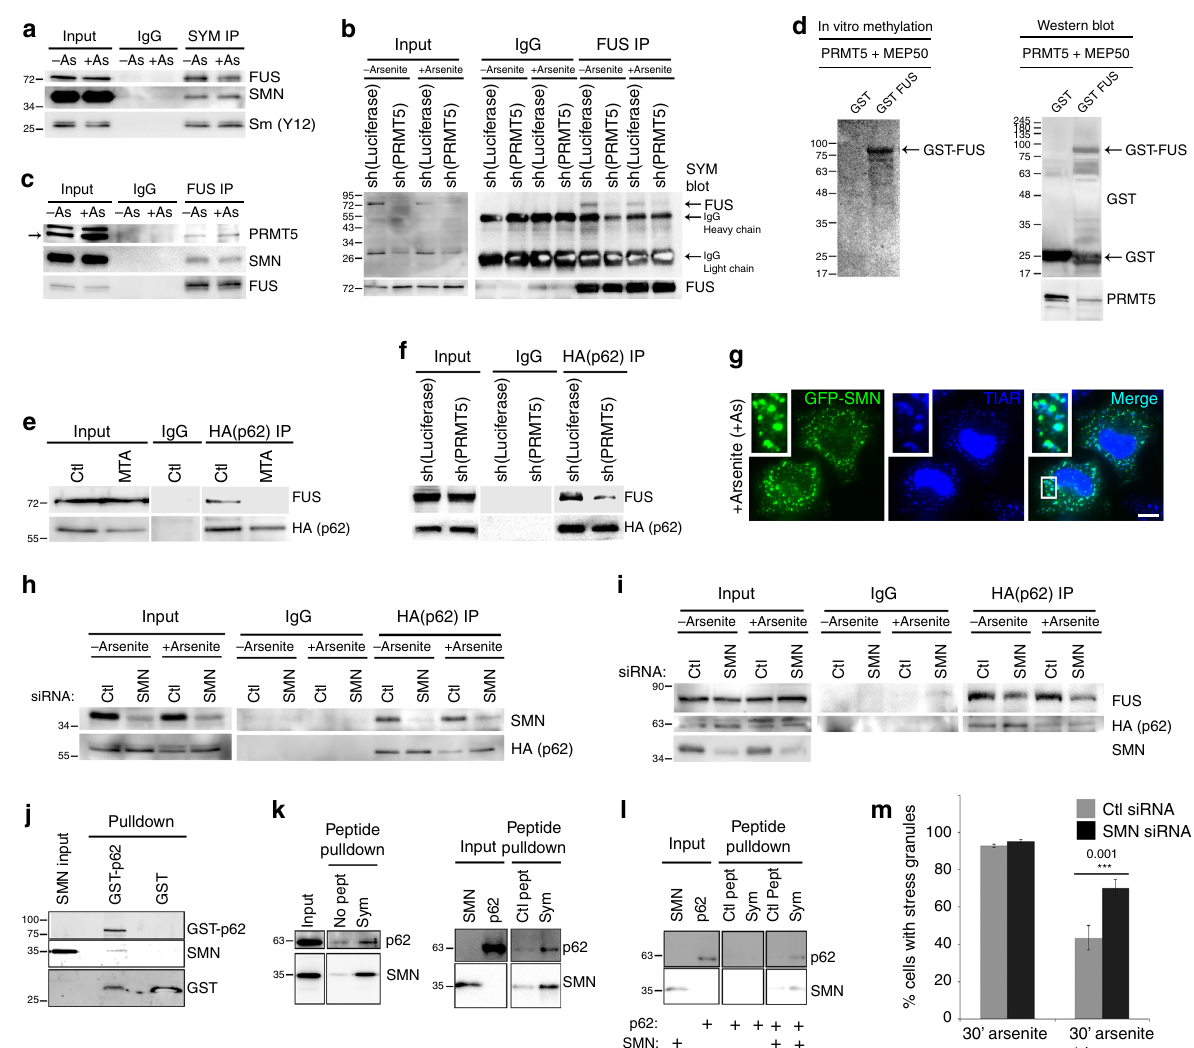
Fig. 4 SMN mediates the interaction of p62 with FUS methylated by PRMT5 for degradation by autophagy. a Western blot of immunoprecipitates of endogenous proteins containing symmetrically dimethylated arginines from cells treated with arsenite ( + As) or not ( − As). b Western blot for proteins containing symmetrically dimethylated arginines in immunoprecipitates of FUS from cells stably expressing PRMT5 shRNA or control shRNA; top arrow indicates mass of FUS on western blots and bottom arrows indicate bands due to detection of immunoprecipitating IgG heavy and light chain. c Western blot of immunoprecipitates of FUS from cells with and without arsenite treatment ( + As, − As); A non-speci fi c band appears above PRMT5 in PRMT5 input western blots that is not depleted by shRNA targeting PRMT5 (see Supplementary Fig. 3e). d Left, autoradiograph of (3)H after in vitro methylation assay of GST or GST-FUS incubated with PRMT5-MEP50; Right, western blot of PRMT5 and GST in samples used for in vitro methylation assays (Right). e Western blot of HA-p62 immunoprecipitates in cells treated with DMSO (Ctl) or MTA (methylthioadenosine 1 mM, 48 h). f Western blot of FUS in HA- p62 immunoprecipitates from cells stably expressing PRMT5 or control shRNA. g Immuno fl uorescent microscopy of GFP-SMN and TIAR (stress granule marker) in cells treated with arsenite. h Western blot of SMN in immunoprecipitates of HA-p62 from cells treated with SMN or control siRNA and either treated or not with arsenite. i Western blot of FUS in immunoprecipitates of HA-p62 from cells treated with siRNA targeting SMN or control (Ctl) and either treated or not with arsenite. j Western blot of recombinant SMN and GST-p62 from in vitro GST-pulldown assay. k Western blot of recombinant p62 and SMN from in vitro pulldown of control (Ctl) or symmetrically dimethylated peptides (Sym) incubated with recombinant p62 and SMN. l Western blot of recombinant p62 and SMN from in vitro pulldown of peptides incubated with recombinant p62 alone or p62 and SMN. m Percentage of cells transfected with control (Ctl) or SMN siRNA containing stress granules following 30 min arsenite treatment or following 1 h recovery from arsenite ( n = 6, mean ± SD, Student ’ s t -test). HeLa cells were used in all experiments. Scale bar = 10 µ m